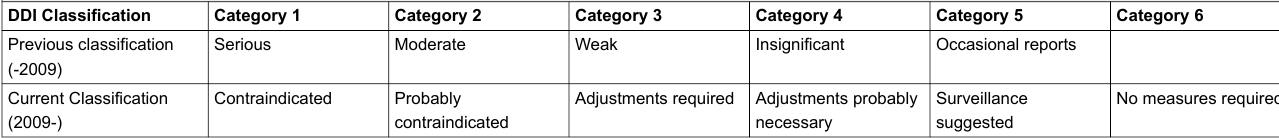
Table 1 The seriousness classification used within the currently used Swiss drug-drug-interaction DDI database GALDAT. The number of categories as well as the distribution of DDI changed in November 2009 with a new category being implemented. As the changes occurred within the year of 2009, results in table 2 show a transition period in